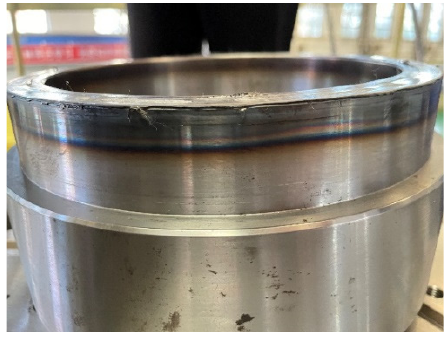
Figure 1. Burn and wear scars on the sleeve after severe TDB failure.